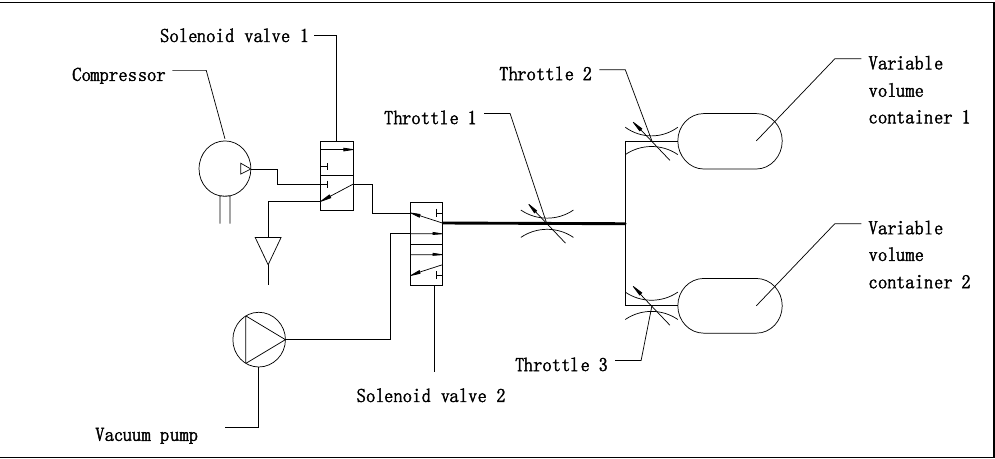
Figure 2. Equivalent pneumatic system.